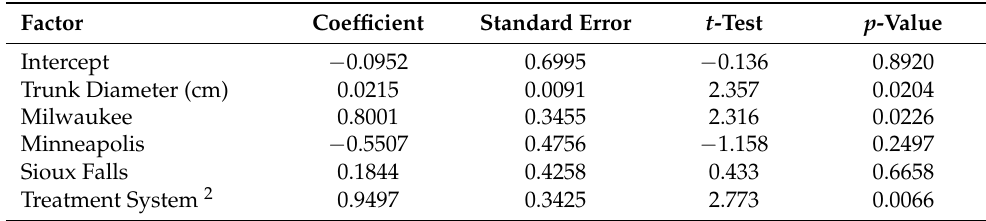
green ash ( Fraxinus pennsylvanica Marshall) trees 1